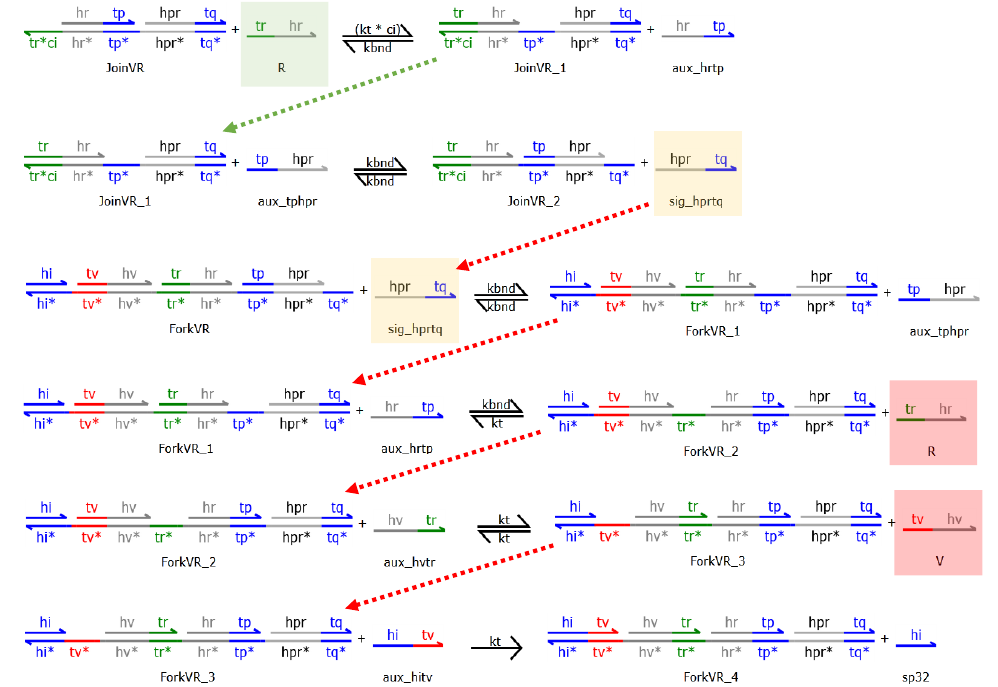
Figure 7. An example of a set of DSD reactions in which their dynamics are equivalent to a catalysis k t × c i −−−→ R + V generated in Visual DSD utilising the Join - Fork templates following [9]. The reaction R toehold <tr*ci> in the complex JoinVR contains a complementarity degree to the signal toehold <tr> of 0 < c i ≤ 1. This slows down the reaction mediated by <tr> and <tr*ci> to k t × c i , where k t is the maximum binding rate of two complementary toeholds <tr> and <tr*>